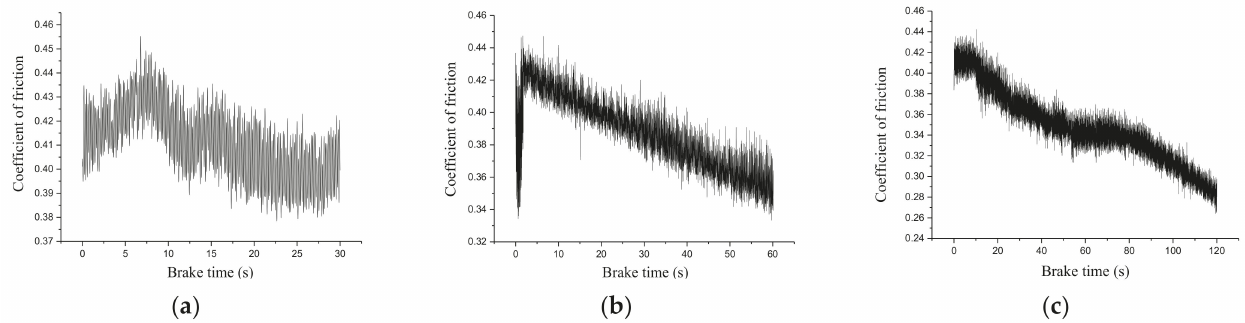
Figure 18. Evolutions of coefficient of friction between the brake disc and the brake shoe in cases of different emergency braking times. ( a ) 30 s ( b ) 60 s ( c ) 120